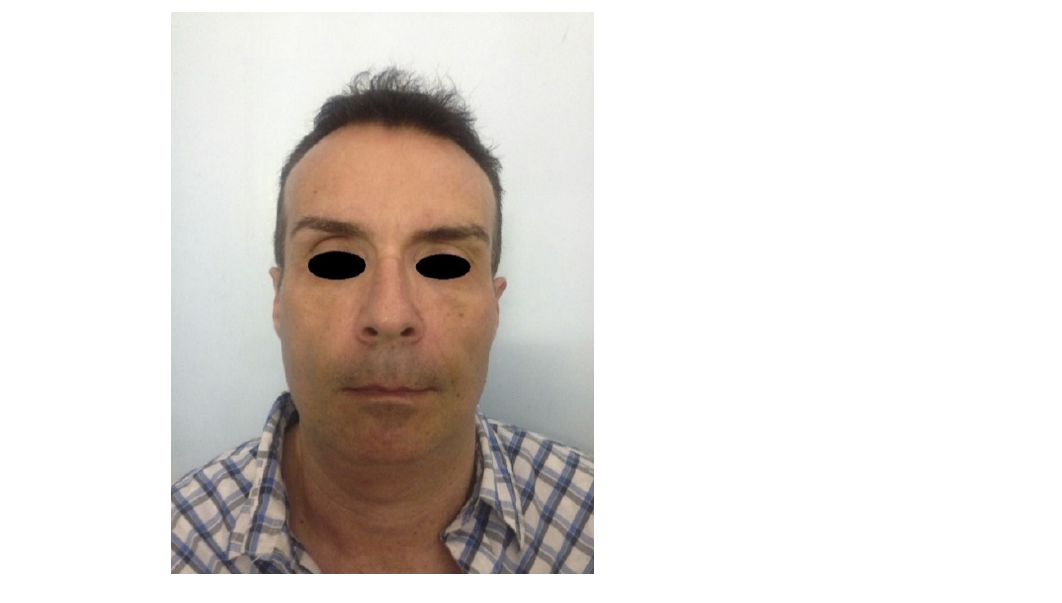
Figure 5. Frontal view of a patient presenting facial wasting and submental fullness (the same patient shown in Figure 4) treated with CaHA injection, at 3 months follow-up.